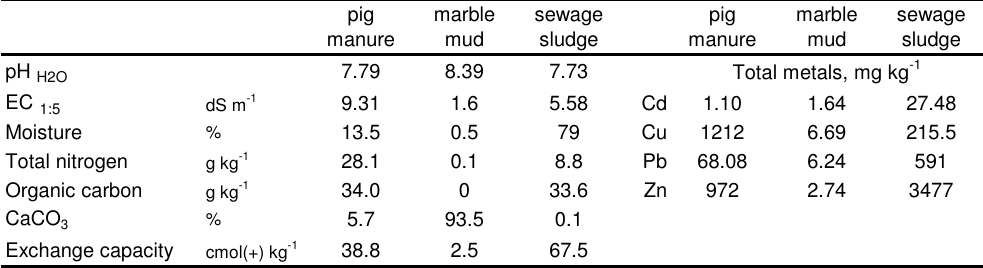
Chemical Properties of Pig Manure, Marble Mud, and Sewage Sludge